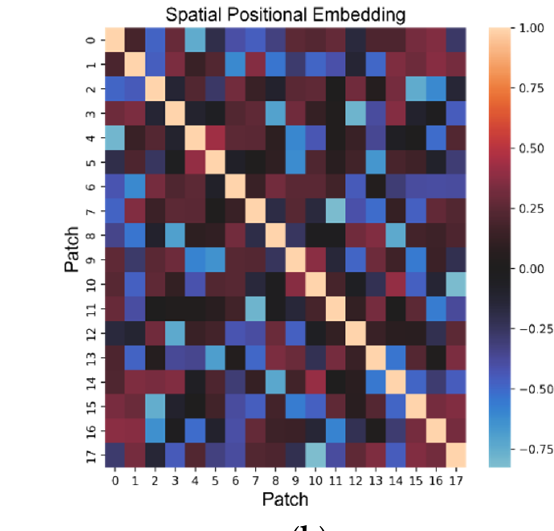
( b ) Figure 8. Cosine similarity of temporal position embedding. ( a ) The left side shows the position embed- ding for the encoder part. ( b ) The right side shows the position embedding for the decoder part. 2.7.2. Spatial Information Like the sequence of timesteps, for the identification of the location of the measured region, the Transformer model also needs additional information expressing the unique 1D code of the given location. These identification codes are also expressed by a vector that is added to the input features. The network trains these identifiers by itself; thus, it can mark sites with similar meanings with a similar vector and, conversely, mark sites with no direct correlation with significantly different vector values. From Figure 9, it is possible to see the related regions, which, in most cases, overlap on the map of India. From